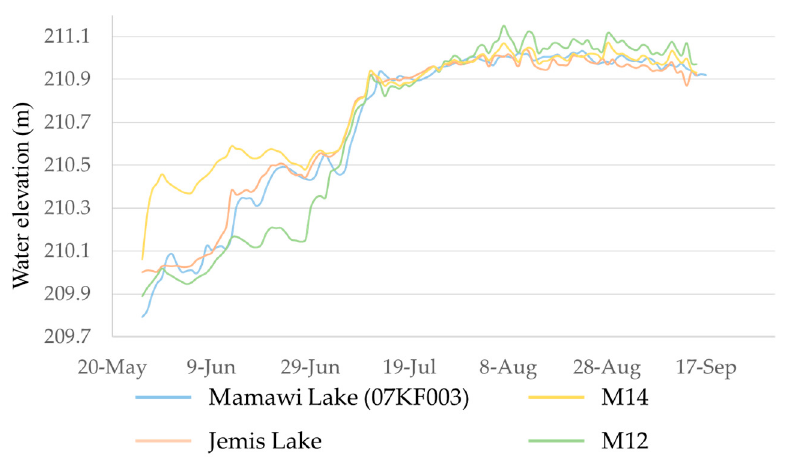
Figure 10. Water levels of Mamawi Lake and surrounding Jemis Lake, M12 and M14.